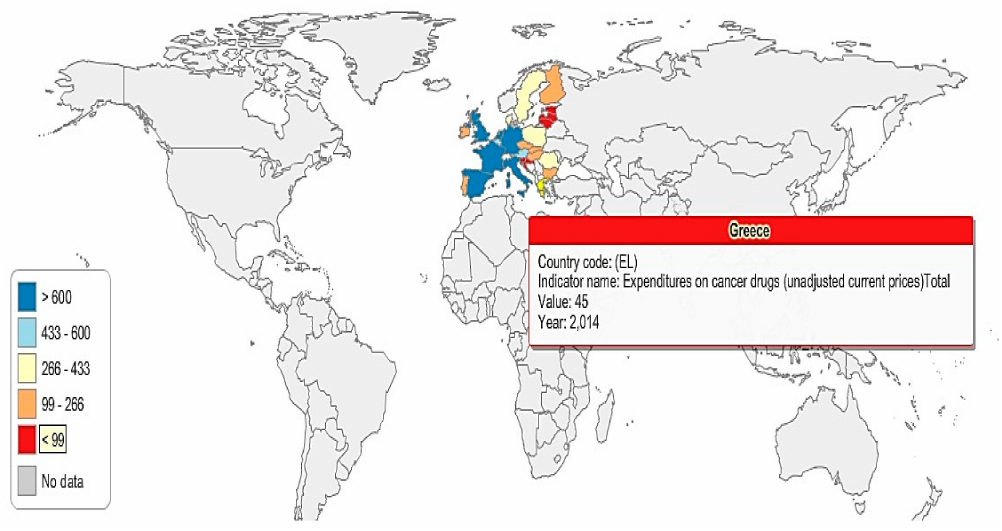
Figure 6. Anti-cancer drug expenditure map, Greece and the 26 EU countries,